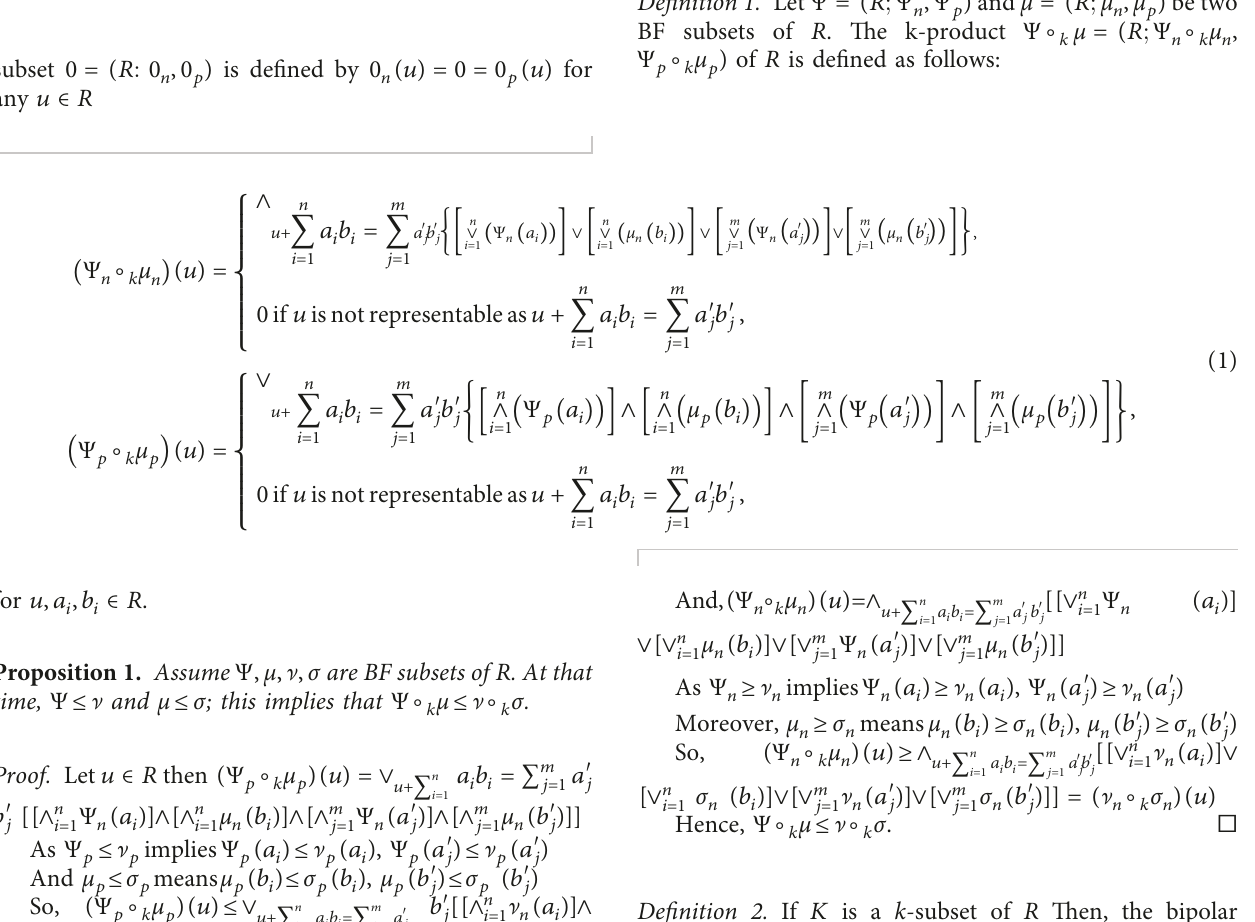
Figure 1: Fuzzy set.